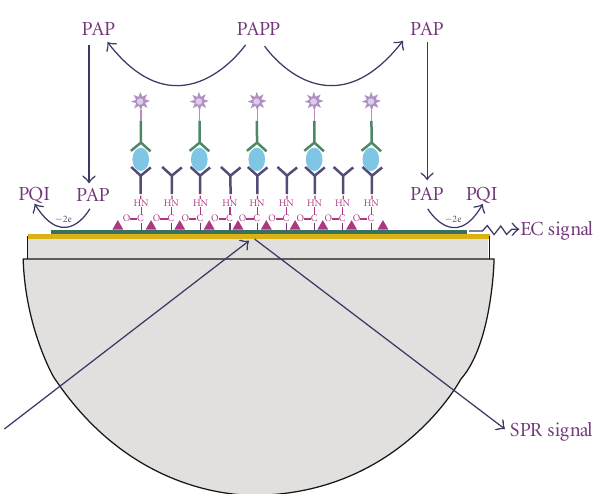
Figure 1: Schematic diagram of in situ EC-SPR instrument for construction of immunosensor based on polyporrole propylic acid (PPA) film